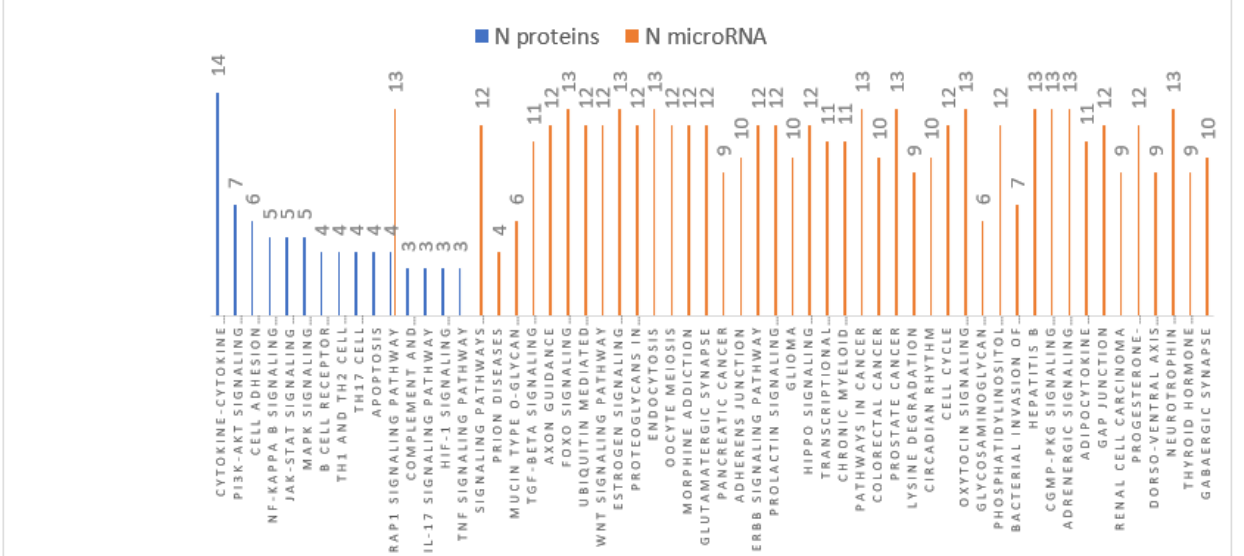
Figure 3. Braak stage III-IV pathways analyses.